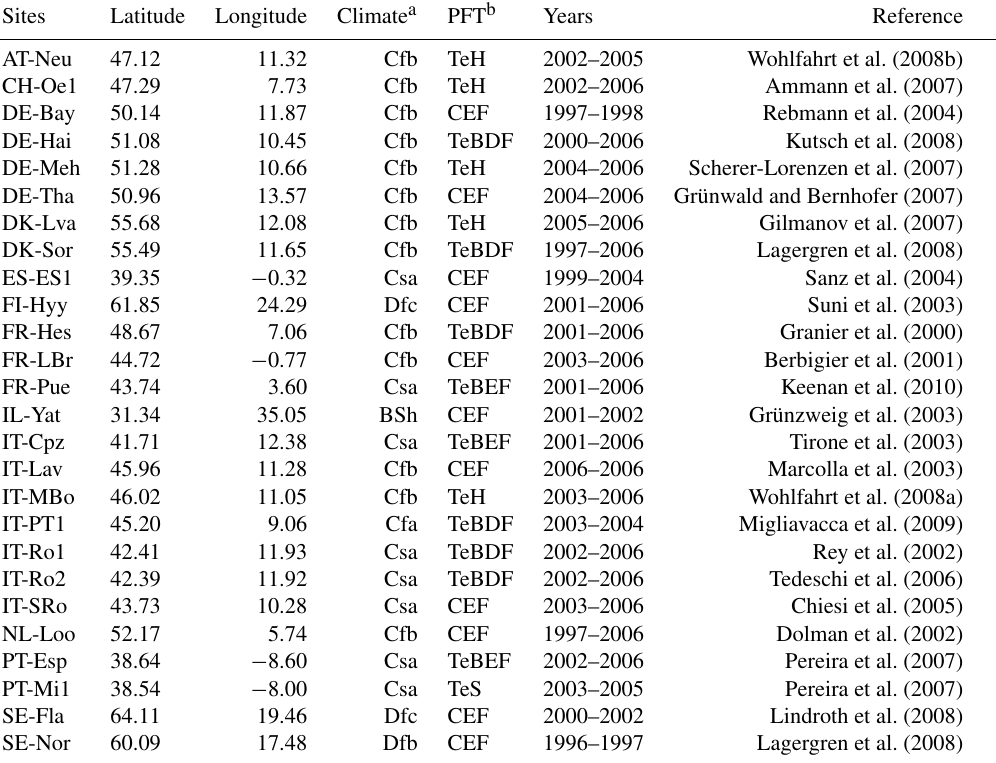
Table A1. Characteristics of the FLUXNET sites used in this study. Sites Latitude Longitude Climate a PFT b Years Reference